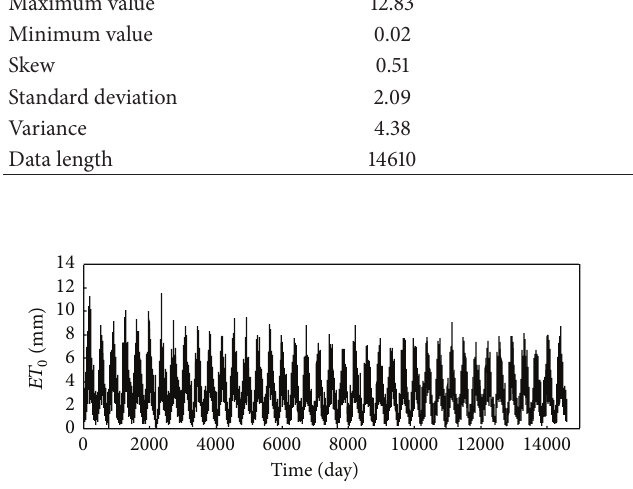
Figure 2: Variation of daily reference evapotranspiration (January 1966–December 2005) from Kaifeng